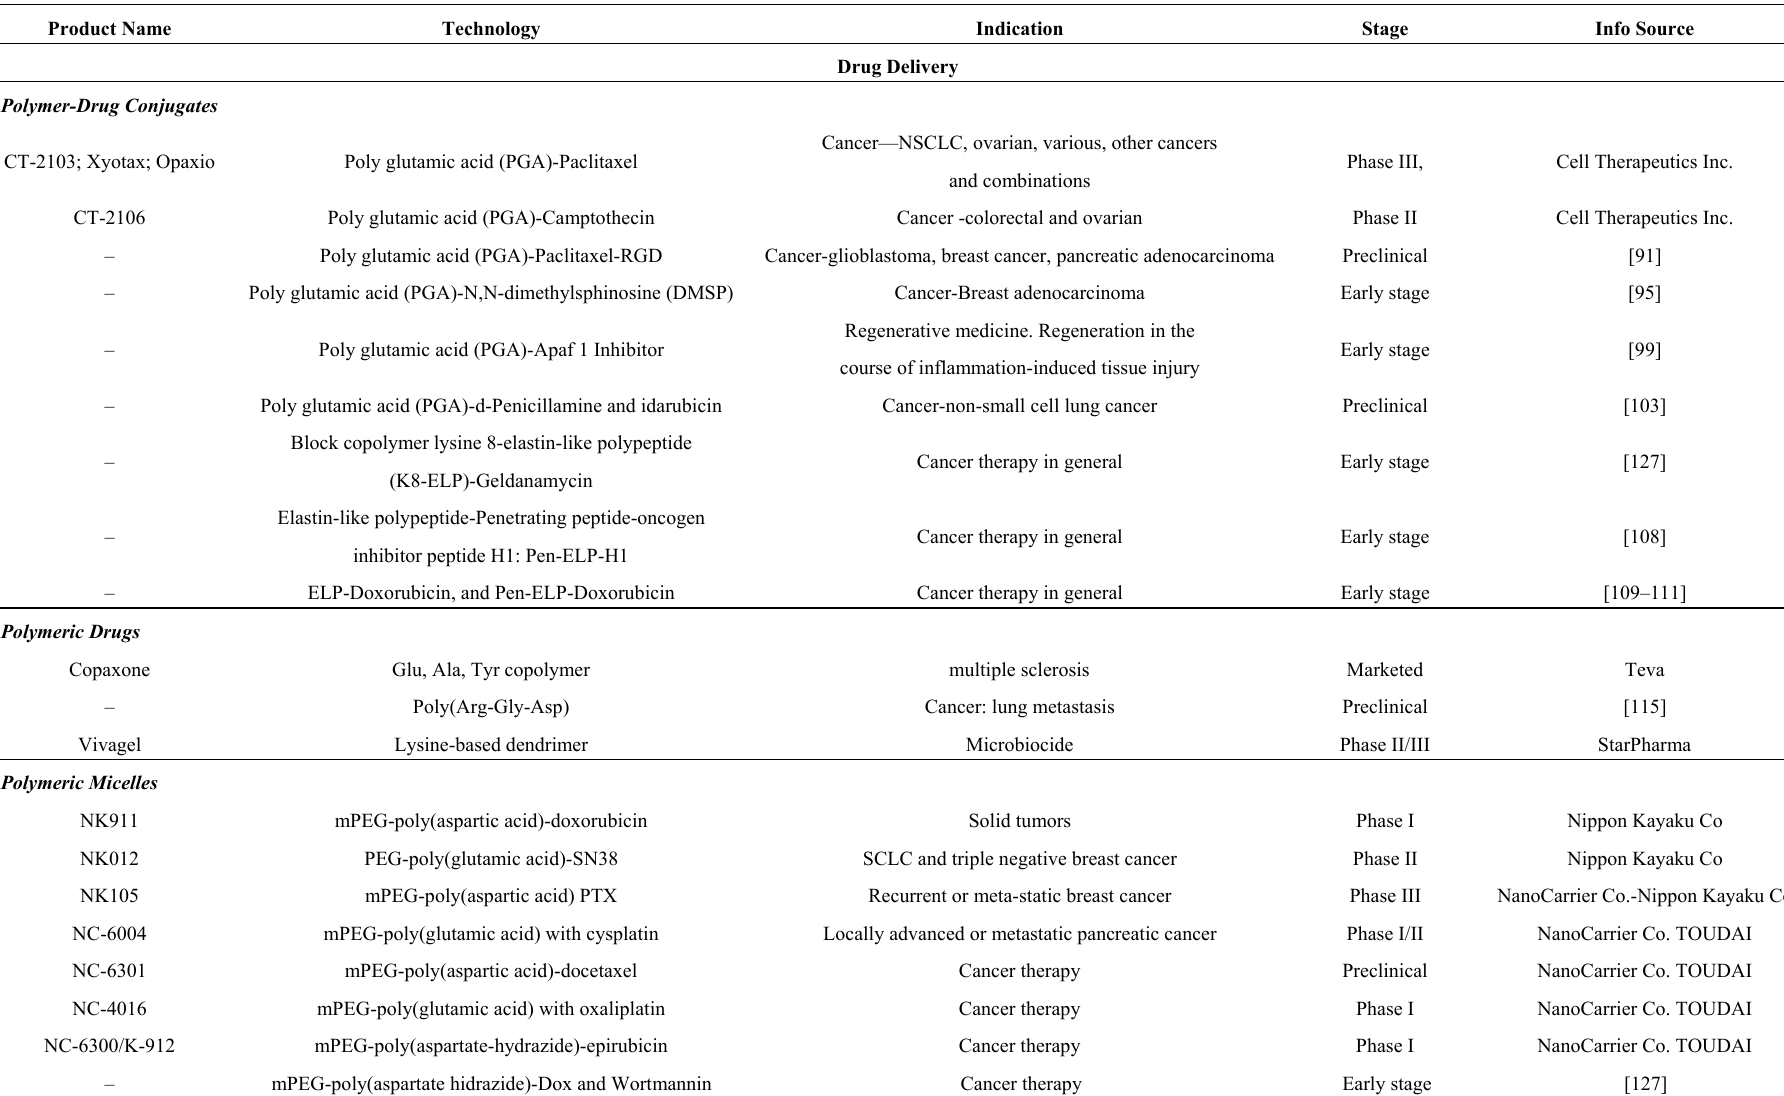
Table 1. Examples of polypeptide-based Polymer Therapeutics in the